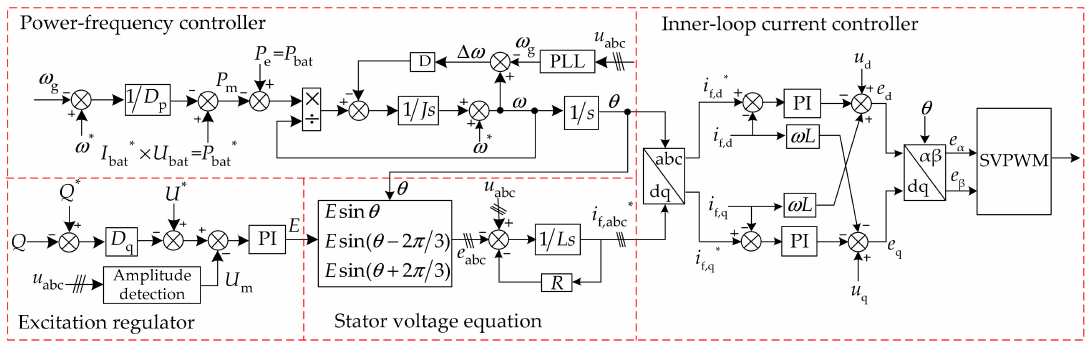
Figure 2. Applied control structure of virtual synchronous motor